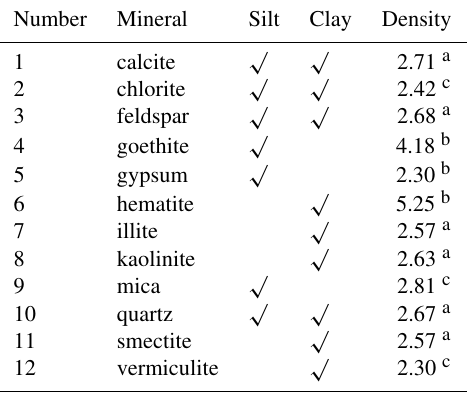
Table 1. List of mineral species used in this study (in alphabetical order). Their possible presence in the soil fraction that consists of silt and clay is also indicated. Densities in grams per centimetre cubed. For the Mica density, being a group of numerous minerals, the density of muscovite is used.